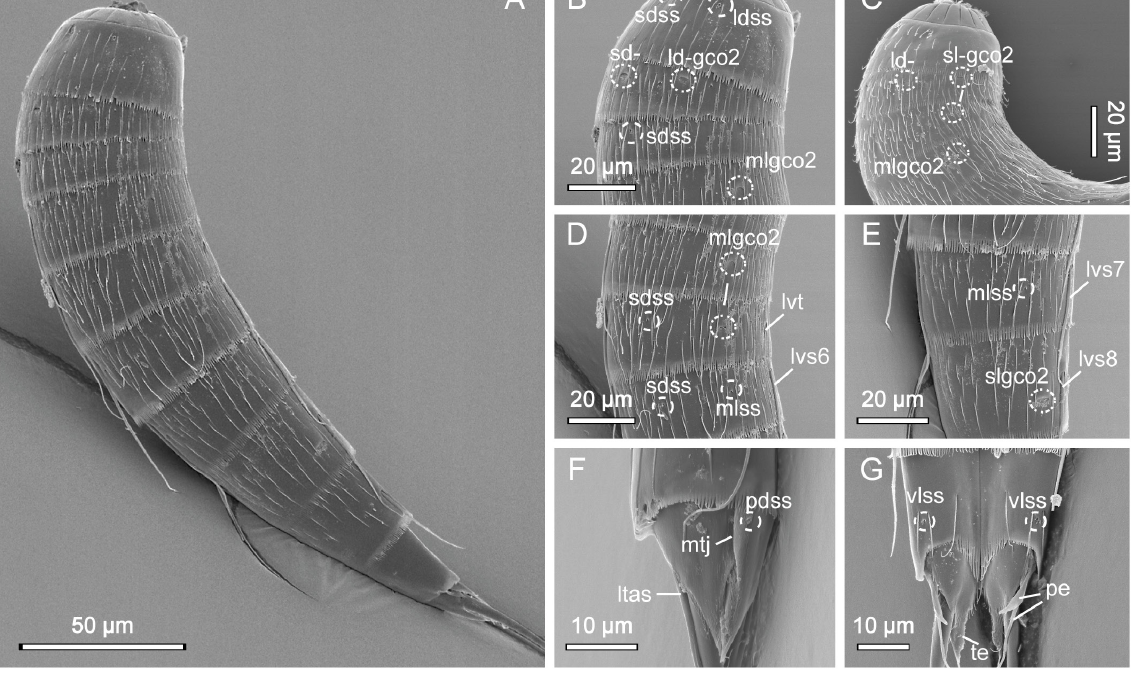
Fig. 39. Scanning electron micrographs showing overviews and details of Echinoderes juliae Sørensen et al ., 2018. A . Lateral overview. B . Segments 1 to 4, laterodorsal view. C . Segments 1 to 4, lateral view. D . Segments 4 to 6, lateral view. E . Segments 7 to 8, lateral view. F . Segments 10 to 11 of female, dorsal view. G . Segments 10 to 11 of male, ventral view. Abbreviations: see Material